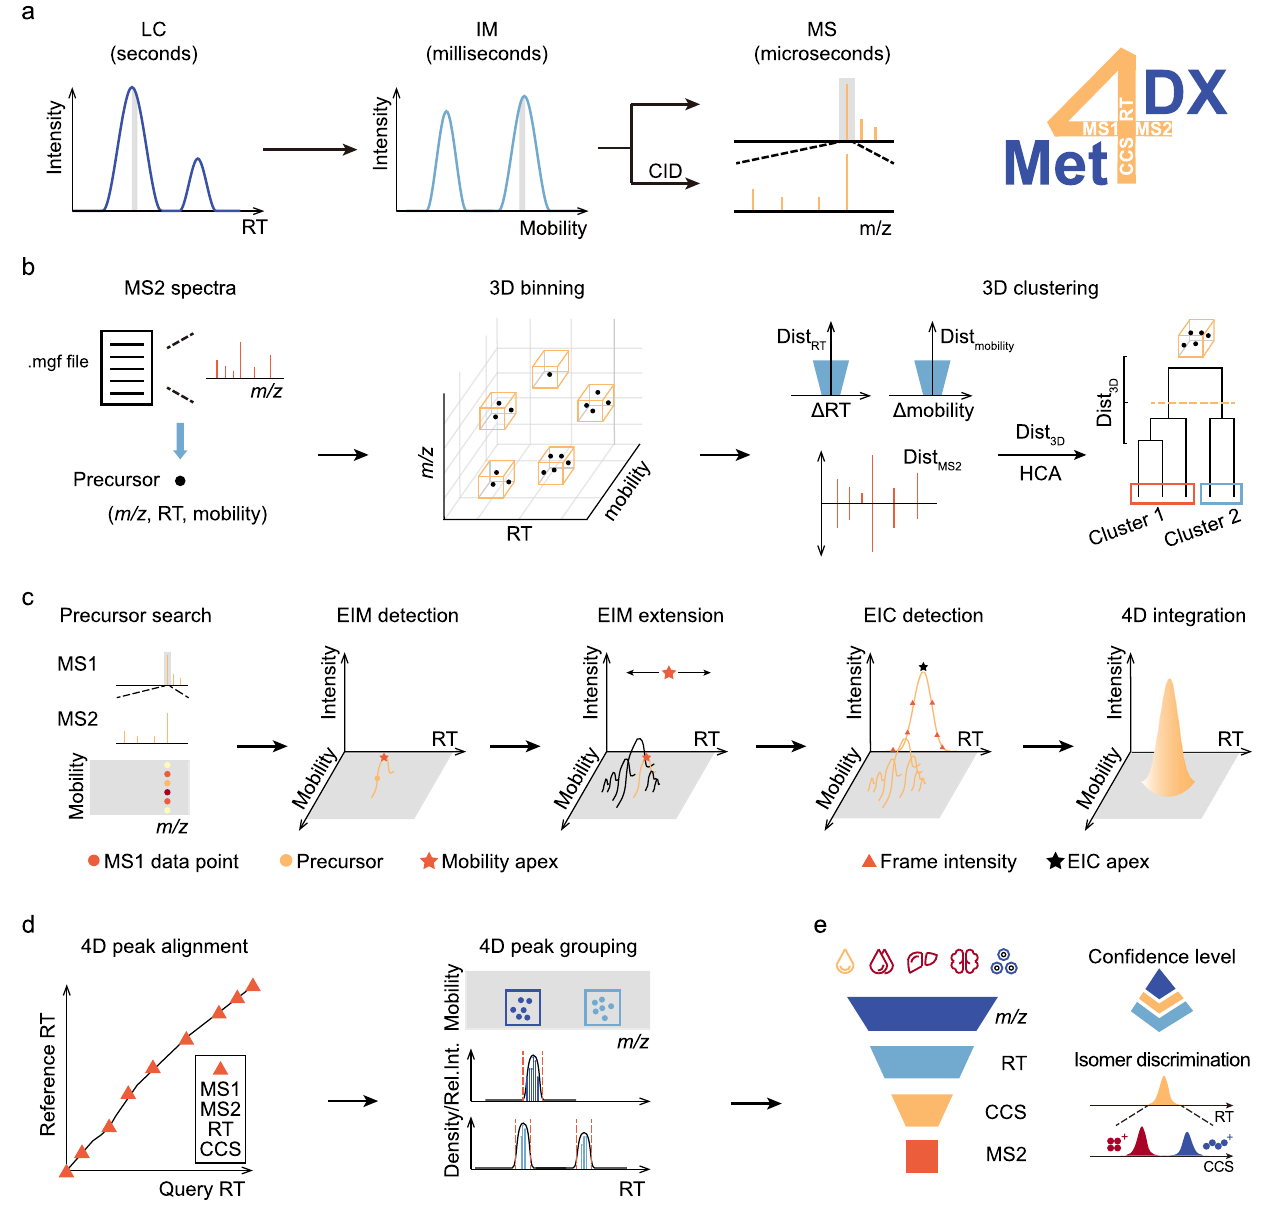
Fig. 1 | The Met4DX work fl ow for ion mobility-resolved untargeted metabo- lomics. a The multidimensional separations and measurements of metabolites using LC – IM – MS/MS technology. b – e Four major modules in Met4DX: b MS2 spectral dereplication; c the bottom-up assembly algorithm for 4D peak